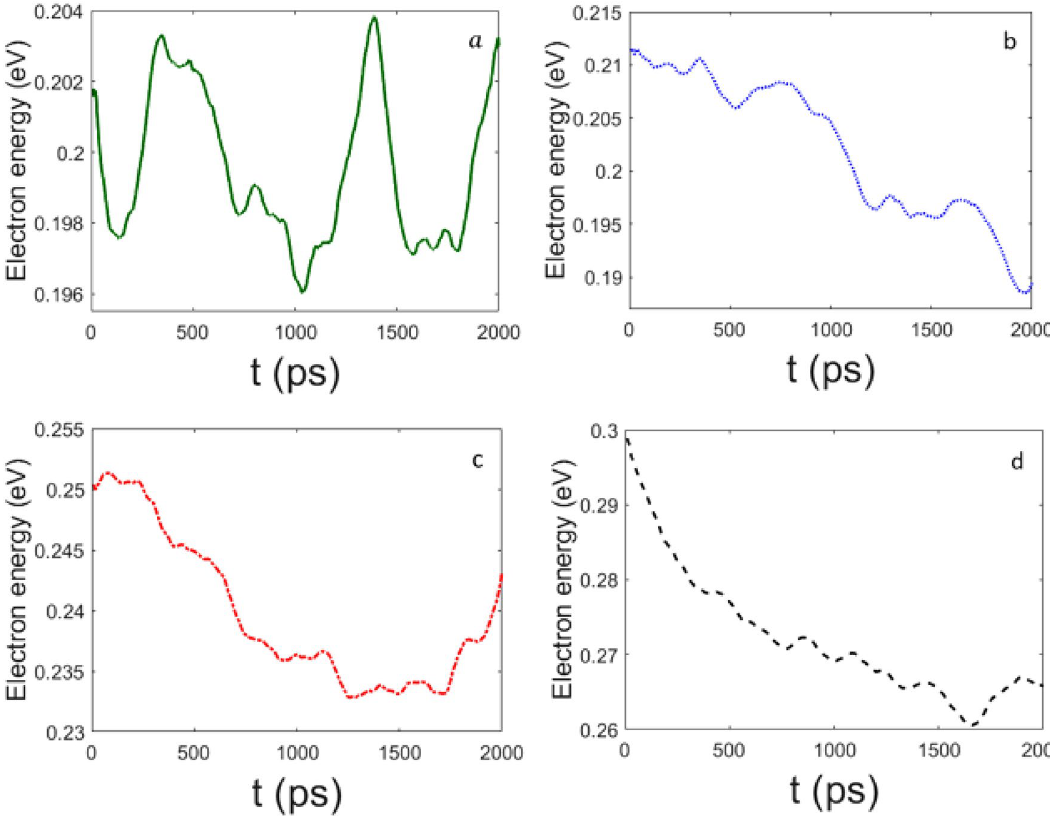
0 , ( b ) ǫ 1 ( ǫ 6.58 meV), ( c ) ǫ ′ = = =